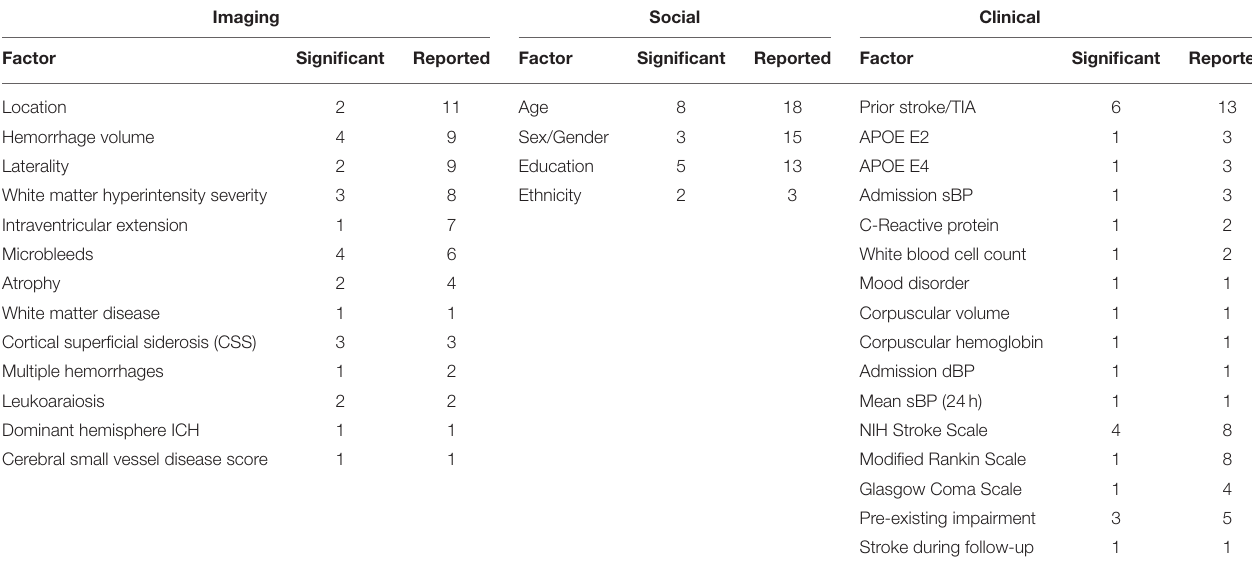
TABLE 6 | Summary of significant factors identified across reports included in the